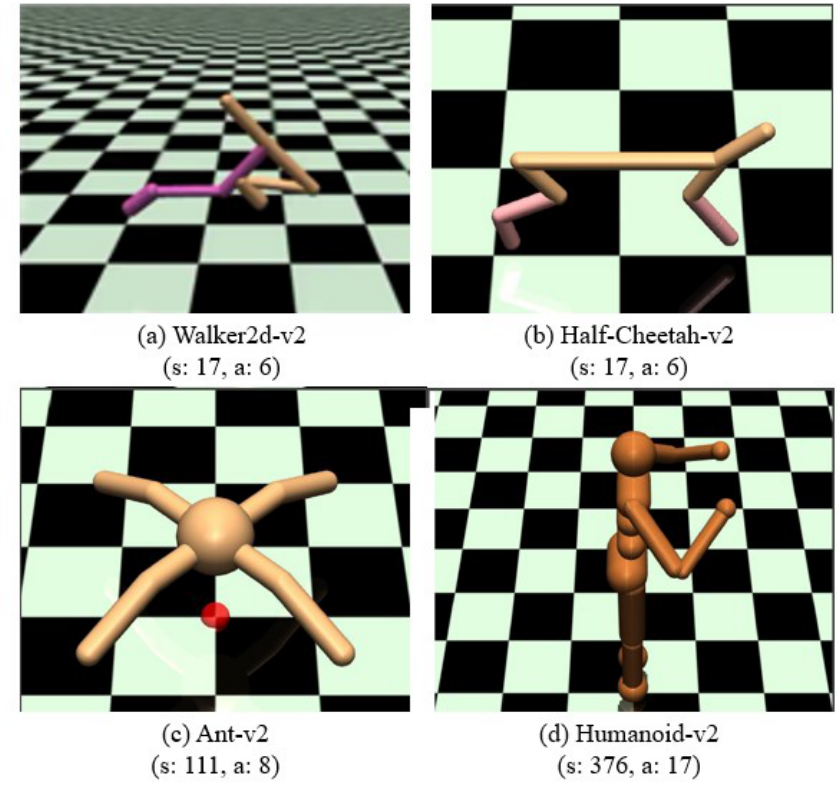
Figure 2. Mujoco robot learning tasks used for skill transfer